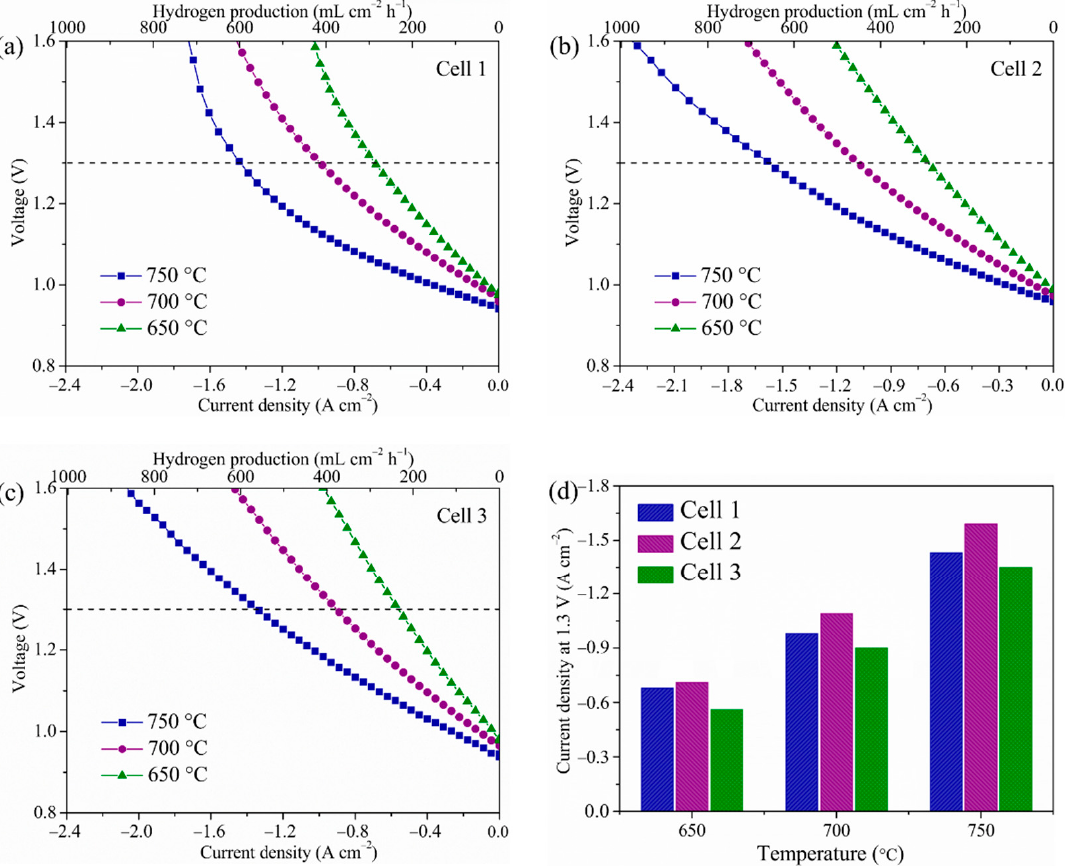
Figure 8. Voltage versus current density measured at different temperatures in air and 50 vol.% H 2 -50 vol.% H 2 O. ( a ) Cell 1, ( b ) Cell 2, ( c ) Cell 3, and ( d ) comparison of the current densities at 1.3 V of the three cells at different temperatures. Table 3. Comparison of the electrochemical performance of various SOECs for H 2 O electrolysis. Temp. Gas j (A cm − 2 ) Cell Composition ( ◦ C) Composition at 1.3